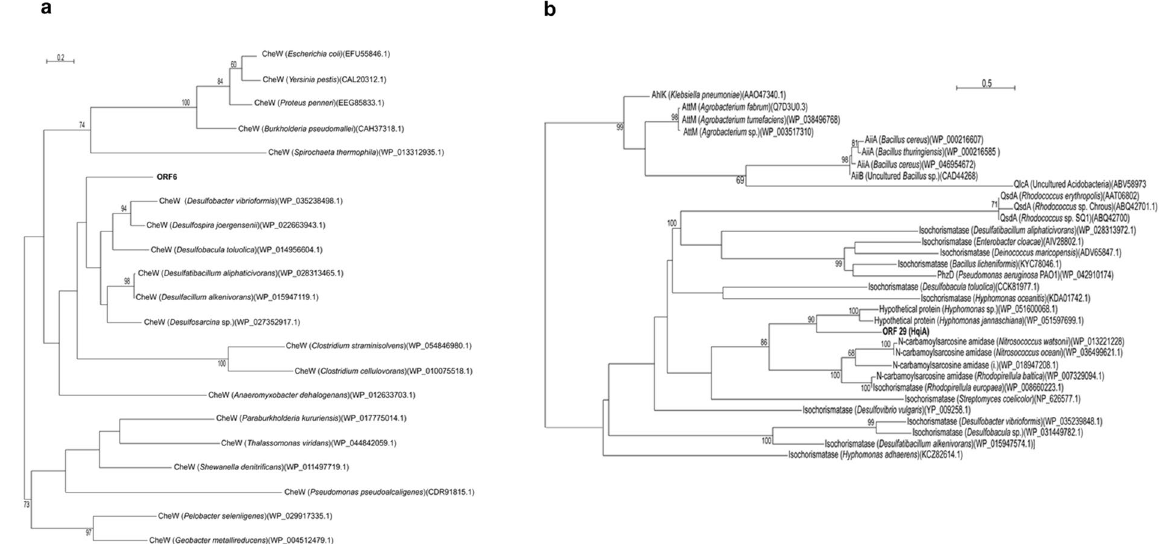
Figure 4. Phylogenetic analysis of the ORFs found in fosmid f10/17.1H based on protein sequences. ( a ) ORF6 as an example of affiliation of ORFs by phylogenetic analysis of representative proteins of each genus identified based on maximum likelihood (phyML). ( b ) Phylogenetic analysis of HqiA showed that it is not related to any known AHL lactonases, otherwise clustering in the cysteine hydrolase group with other hypothetical (HYPO), isochorimatase-like (ISO) and N -carbamoylsarcosine amidase (NCAR)-like